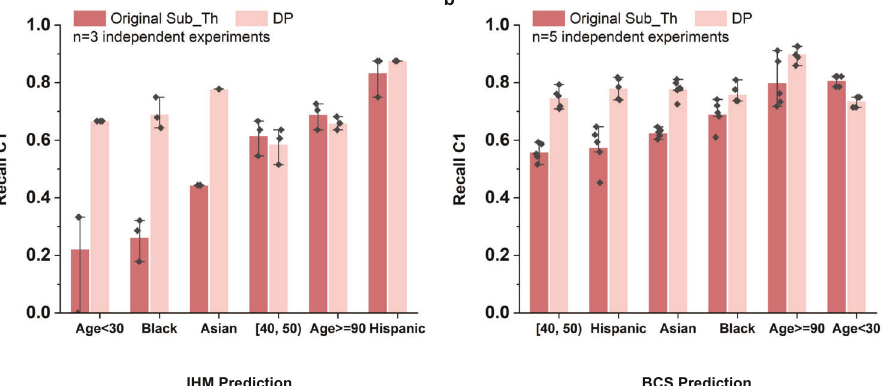
Fig. 7 Performance of DP and subgroup-threshold-based original model in terms of minority class recall for in-hospital mortality (IHM) prediction and 5-year breast cancer survivability (BCS) prediction. Darker red color represents the original model performance using subgroup optimized threshold and lighter red color represents DP performance. The error bars represent the standard error of the experiment results. DP ’ s improvements are stronger when the original recall C1 values are relatively low, partly because DP selects machine learning models based on balanced accuracy. Model performance comparison for a IHM prediction task and b BCS prediction task of 6 different racial or age subgroups. For the IHM prediction task, the standard deviation values for DP are between 0 and 0.051. For the BCS prediction task, the standard deviation values for DP are between 0.017 and